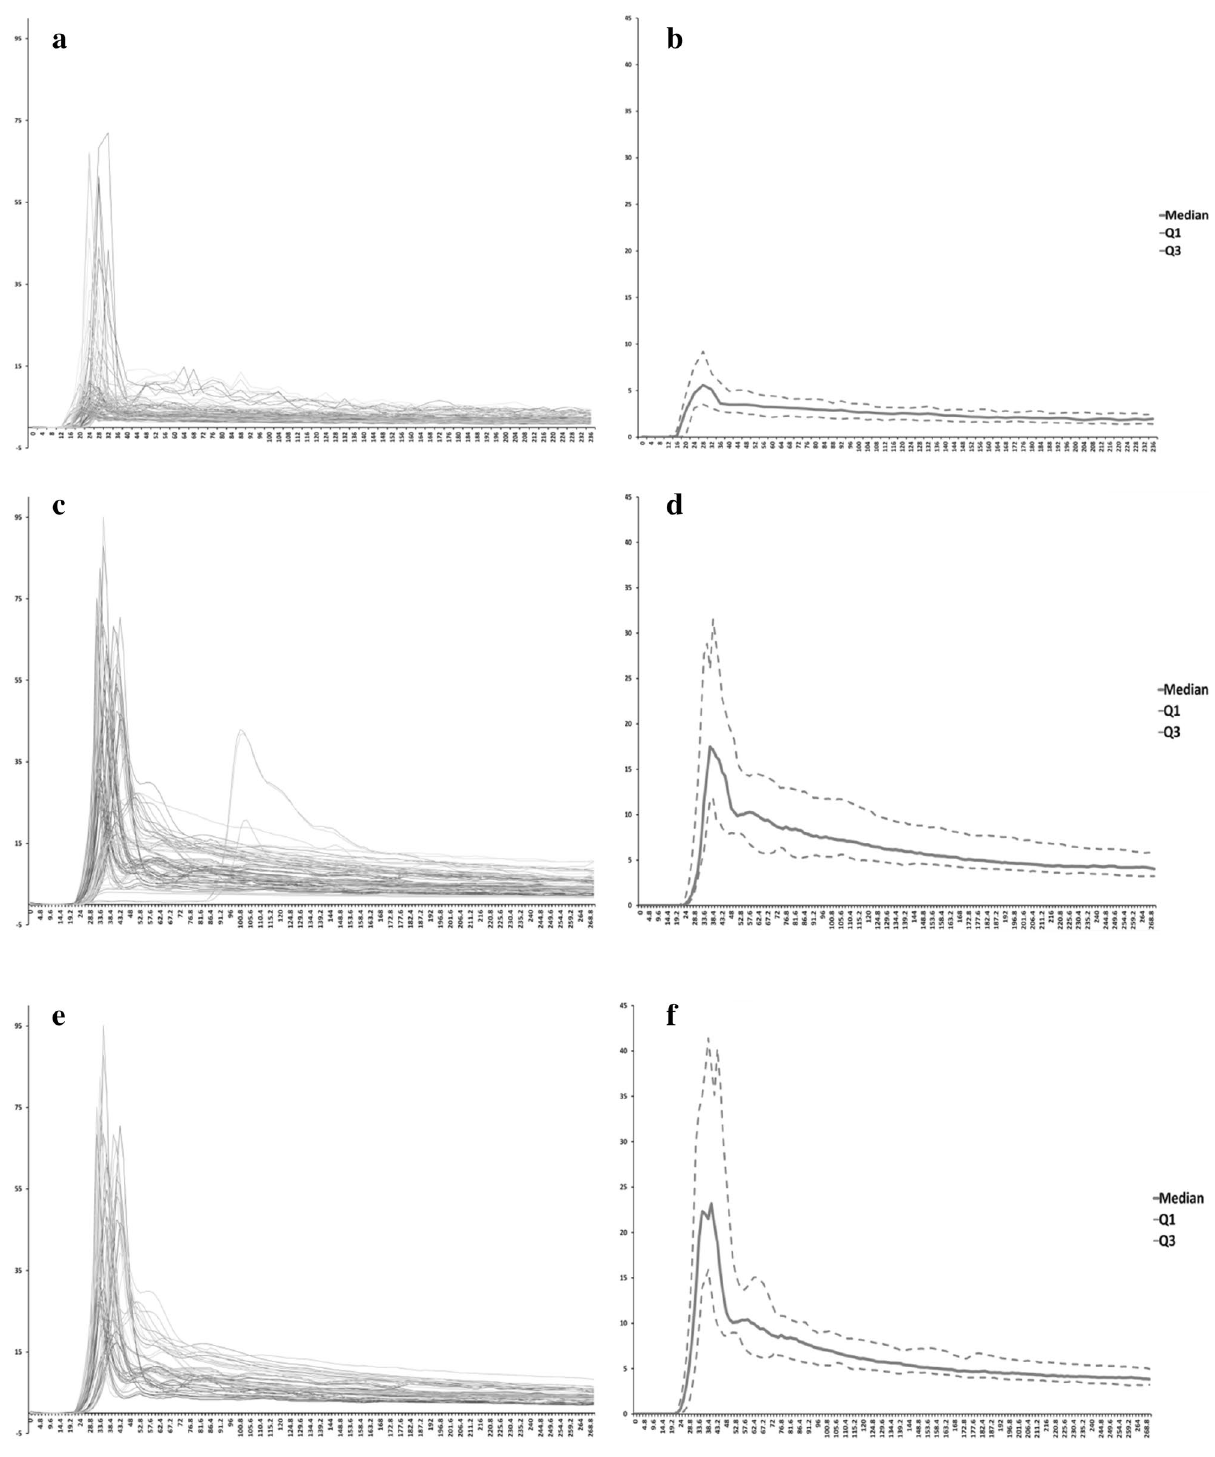
Figure 1. AIFs from C-DCE and HR-DCE MR imaging: ( a ) Individual AIFs of C-DCE MR imaging, ( b ) virtual AIFs derived from C-DCE MR imaging using median, Q1 and Q3 values, ( c ) individual and ( d ) virtual AIFs derived from HR-DCE MR imaging, ( e ) individual and ( f ) virtual AIFs derived from HR-DCE MR imaging after exclusion of suboptimal